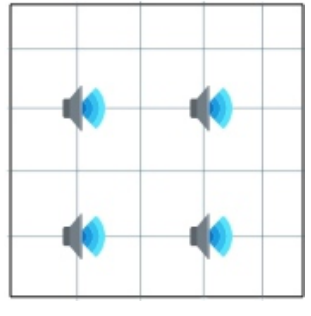
Figure 6. Planar